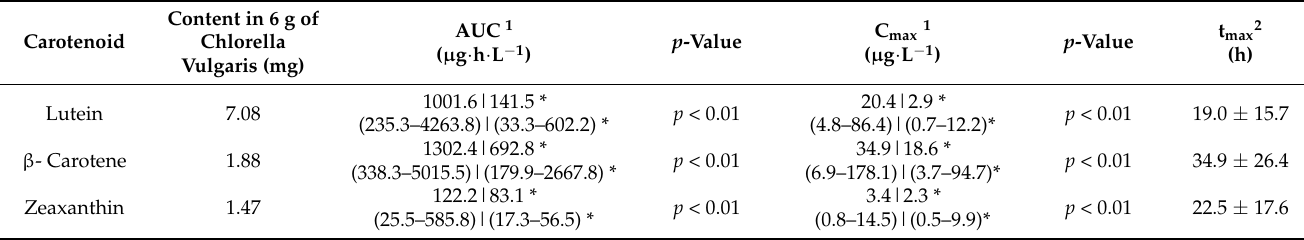
Table 2. Values (mean and range) obtained for AUC, C max and t max for each carotenoid of the 11 participants.